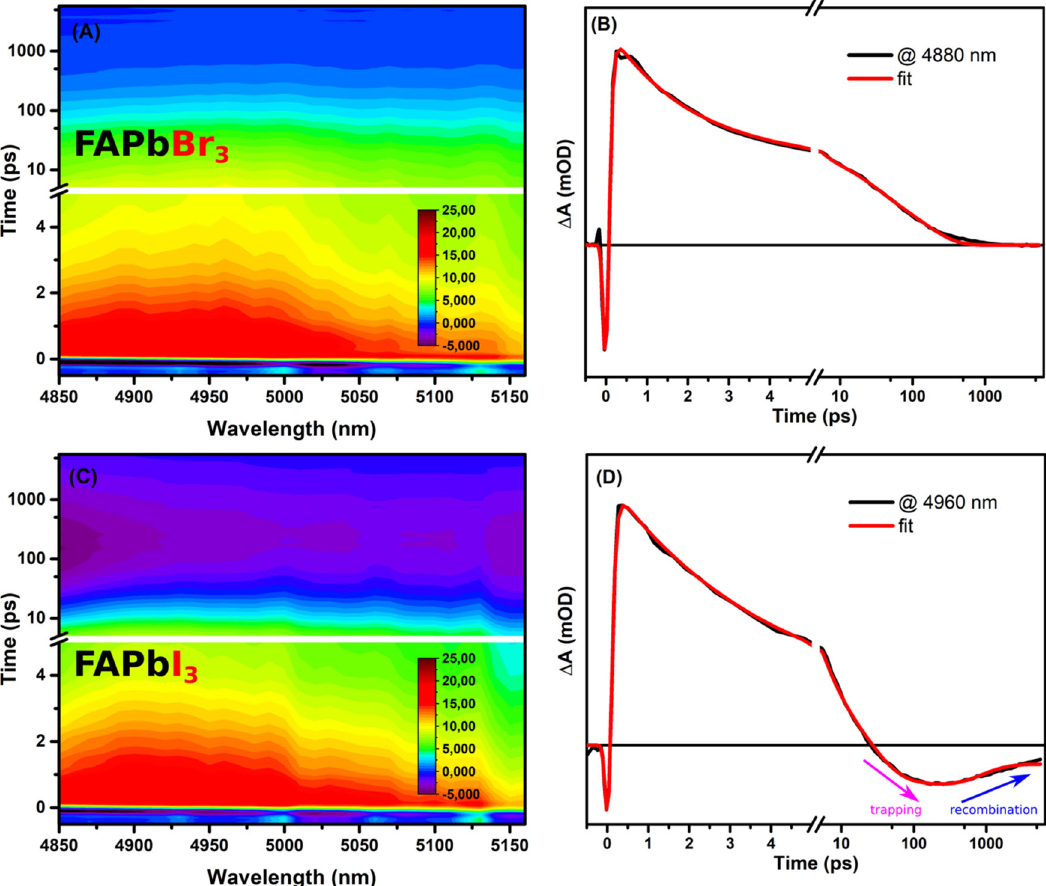
Fig. 3 Transient mid-IR data for MAPb(Br 3 )/I 3 fi lms. ( A ) 2D-false color plot for fs-transient absorption in the mid-infrared regions for FAPbBr 3 fi lm using 530 nm as an excitation source. B Extracted kinetic trace at 4880 nm for FAPbBr 3 fi lm. C 2D-false color plot for fs-transient absorption in the mid-infrared